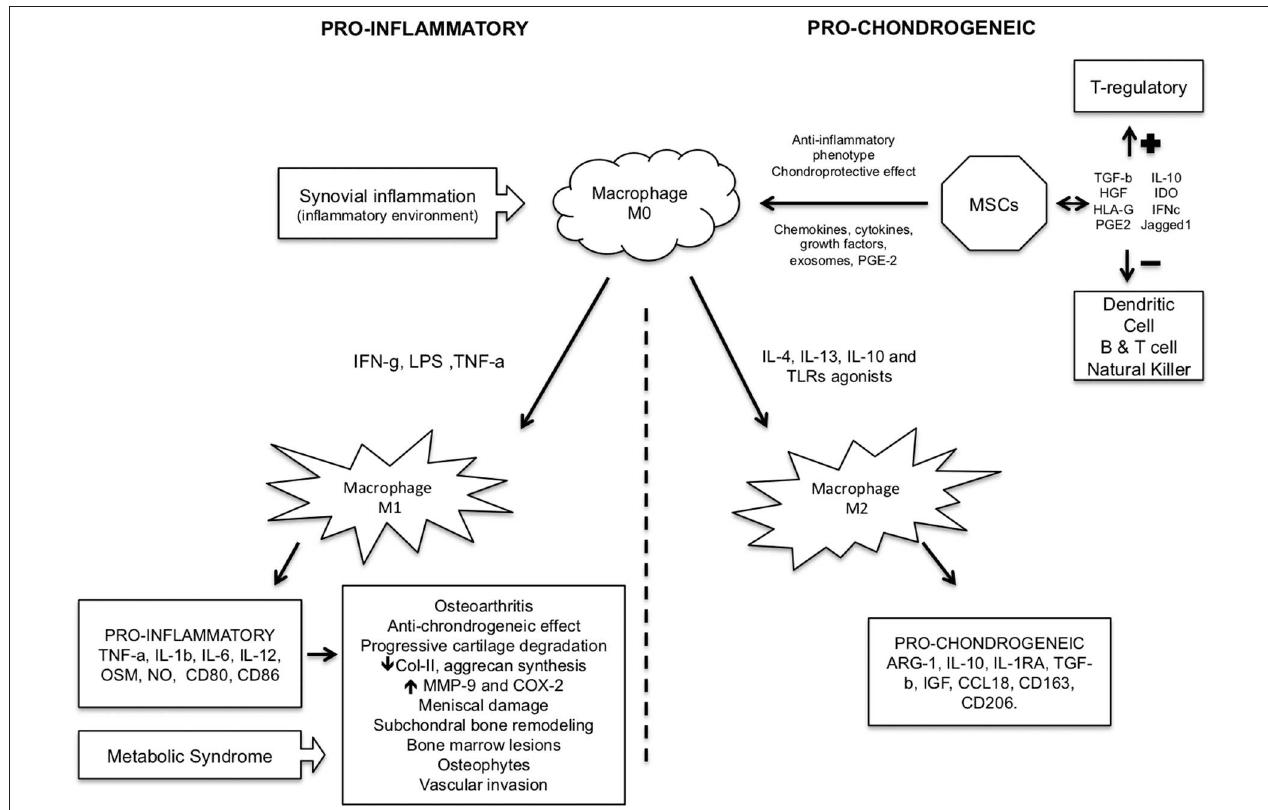
FIGURE 1 | Pro-inflammatory and pro-chondrogeneic macrophage pathways in cartilage